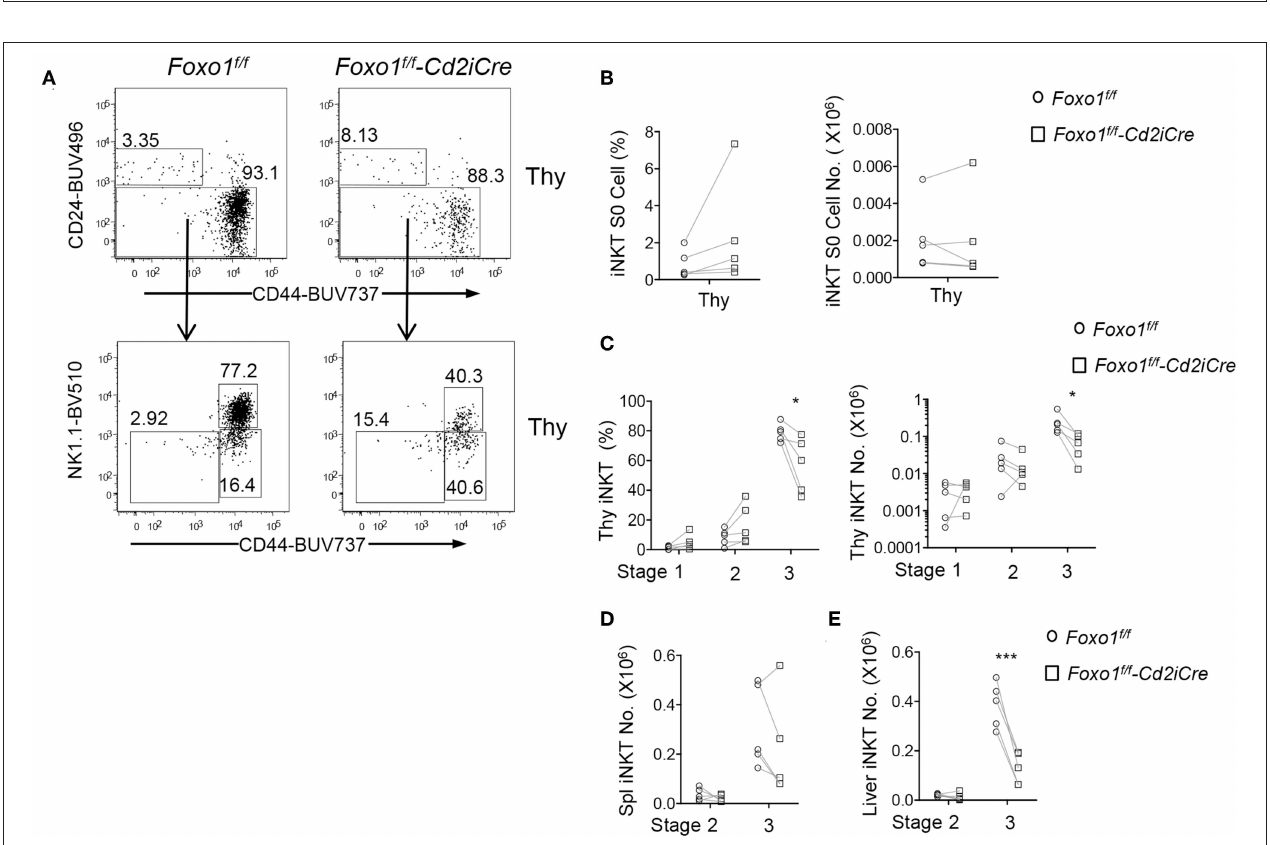
FIGURE 2 | (A) Representative FACS plots showing CD45.1 and CD45.2 staining in splenic Ly6C − Ly6G + CD11b + neutrophils. (B) Scatter plots showing ratios of CD45.2 + to CD45.1 + neutrophils. (C) Representative FACS plots showing CD4 and CD8 staining of live gated thymocytes (left panel) and CD45.1 and 45.2 staining of CD4 + CD8 + DP thymocytes (right panel). (D) Representative FACS plot showing CD1dTet and TCR β staining (left panel) of live gated Lin-thymocytes and CD45.1 and 45.2 staining of gated CD1dTet + TCR β + i NKT cells (top right panel) and CD1dTet − TCR β + non- i NKT cells (bottom right panel). (E) Representative FACS plot